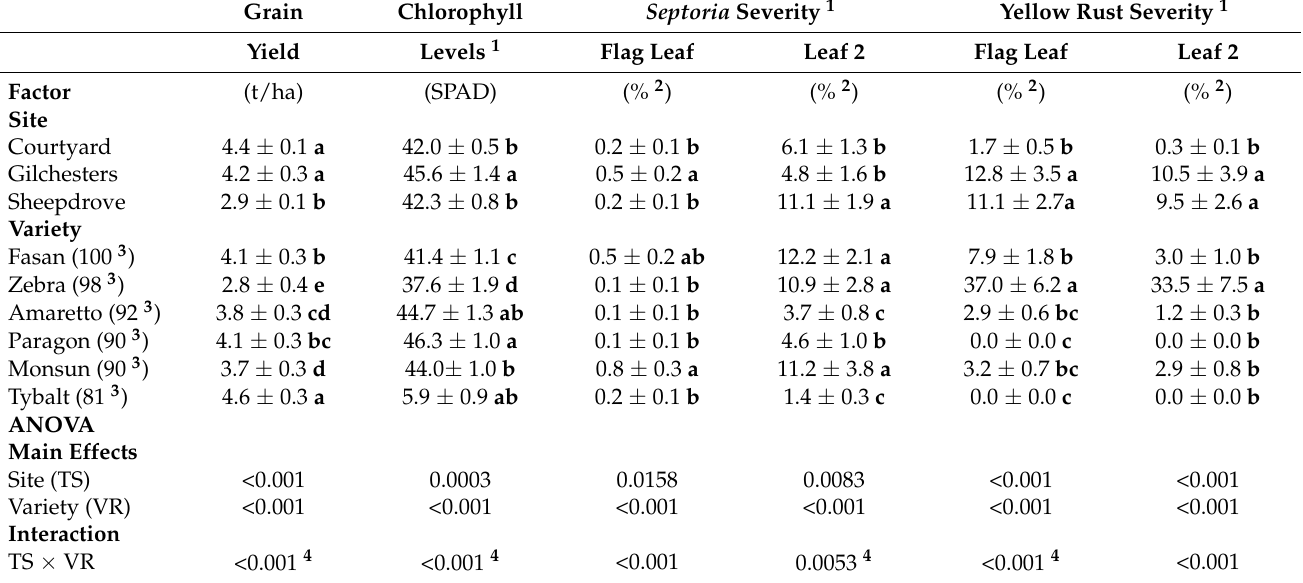
Table 6. Main effect means ± SE and ANOVA results ( p -values) for the effects of site (Courtyard farm, Norfolk, UK; Gilchester farm, Northumberland, UK; Sheepdrove farm, Berkshire, UK) and variety on grain yield, leaf chlorophyll levels (SPAD), and Septoria and yellow rust disease severity in spring wheat ( T. aestivum ) grown under organic management regimes. Results shown are from a re-analysis of data previously published by Wilkinson